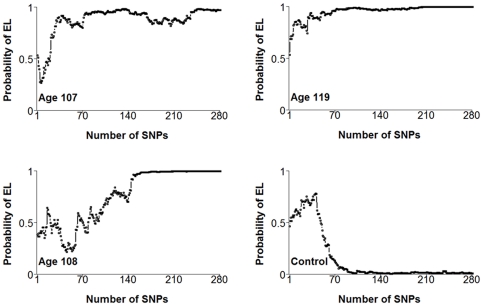
Examples of genetic risk profiles in 4 study subjects (3 centenarians with ages at death 107, 108 and 119 years, and a control).281 nested SNP sets were used to compute the posterior probability of exceptional longevity in the 4 subjects (y-axis) and were plotted against the number of SNPs in each set (x-axis). In the 107 year old, the first 5 SNP sets Σ1 = [rs2075650], Σ2 = [Σ1, rs1322048], …, Σ5 = [Σ4, rs6801173] determine a posterior probability of exceptional longevity ranging between 0.54 and 0.28. This subject carries genotypes AA, AG, AG, CC, AA for the 5 SNPs respectively and, with the exclusion of genotype AA of rs2075650 that is more common in centenarians, the other genotypes are more common in controls than centenarians and determine a posterior probability of exceptional longevity that is lower than the posterior probability of average longevity. The sixth SNP set, Σ6 = [Σ5, rs337656], predicts an almost 30% chance of exceptional longevity. The subject carries the AA genotype for the SNP rs337656 that is more frequent in centenarians (Table S1), and carrying this genotype increases the posterior probability of exceptional longevity. The probability predicted by the next SNP sets increases steadily and all models with more than 20 SNPs predict more than a 50% chance of exceptional longevity. This genetic profile shows that the subject carries some combinations of SNP alleles that are associated with exceptional longevity, while other alleles are associated with “average longevity”. However, the overall genetic risk profile determined by all 281 SNP sets makes a strong case for exceptional longevity because the majority of models predict more than an 80% chance of exceptional longevity. The genetic risk profile of the centenarian who died at age 119 years is even more convincing: with the exception of the first SNP, all subsequent SNP sets determine more than a 70% chance of exceptional longevity, and 272 of the 281 models predict more than an 80% chance for exceptional longevity. This profile shows that this subject is highly enriched for SNPs alleles that are more common in centenarians (longevity associated variants) and that probably played a determinant role in the extreme survival. The profile of the third subject, age 108 years, shows that different SNP sets determine different chances for exceptional longevity, and only the overall trend of genetic risk provides evidence for exceptional longevity. The fourth plot displays the profile of a control, and shows that this subject carries some longevity associated variants; however, the overall trend of genetic risk points to average longevity rather than exceptional longevity.